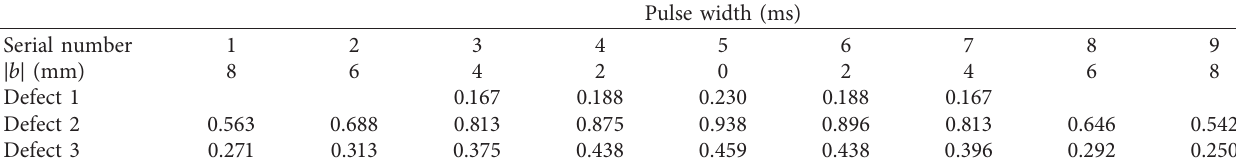
Table 2: Pulse width measurement results at different points in the defective area.